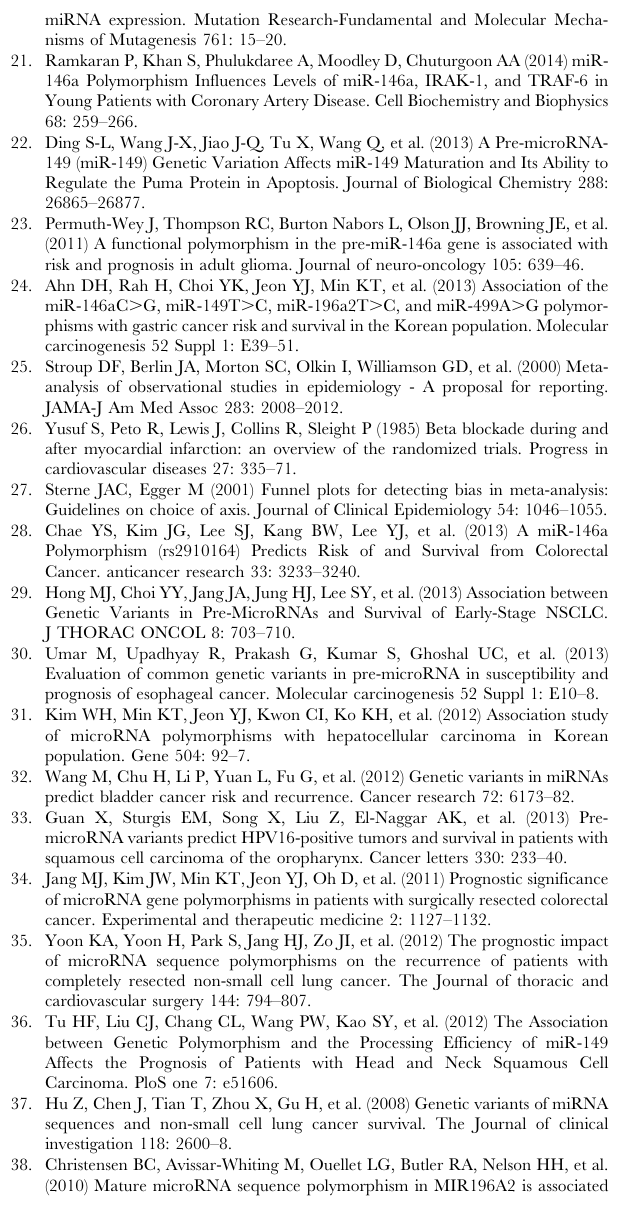
Table S1 Basic information of the articles included in the meta-analysis.